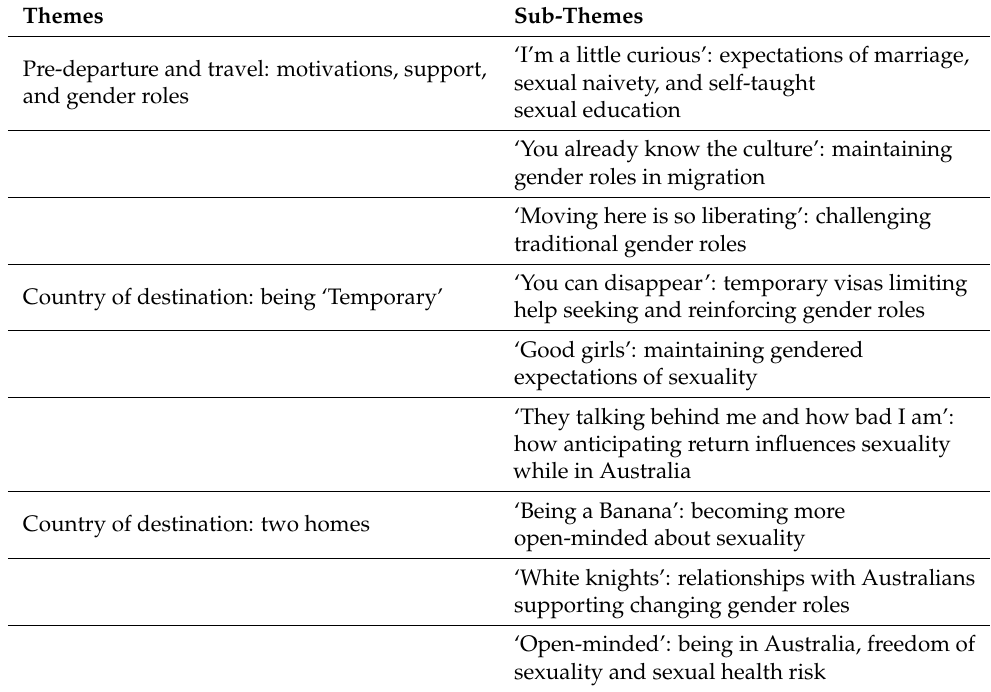
Table 2. Themes and